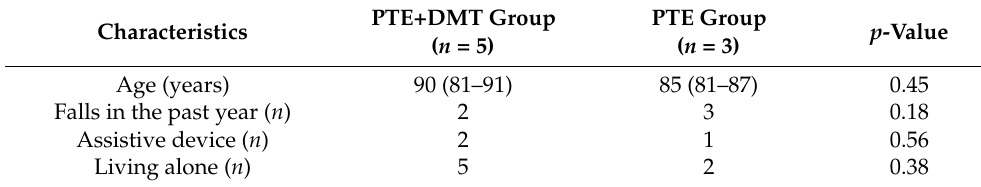
Table 1. Participants’ main